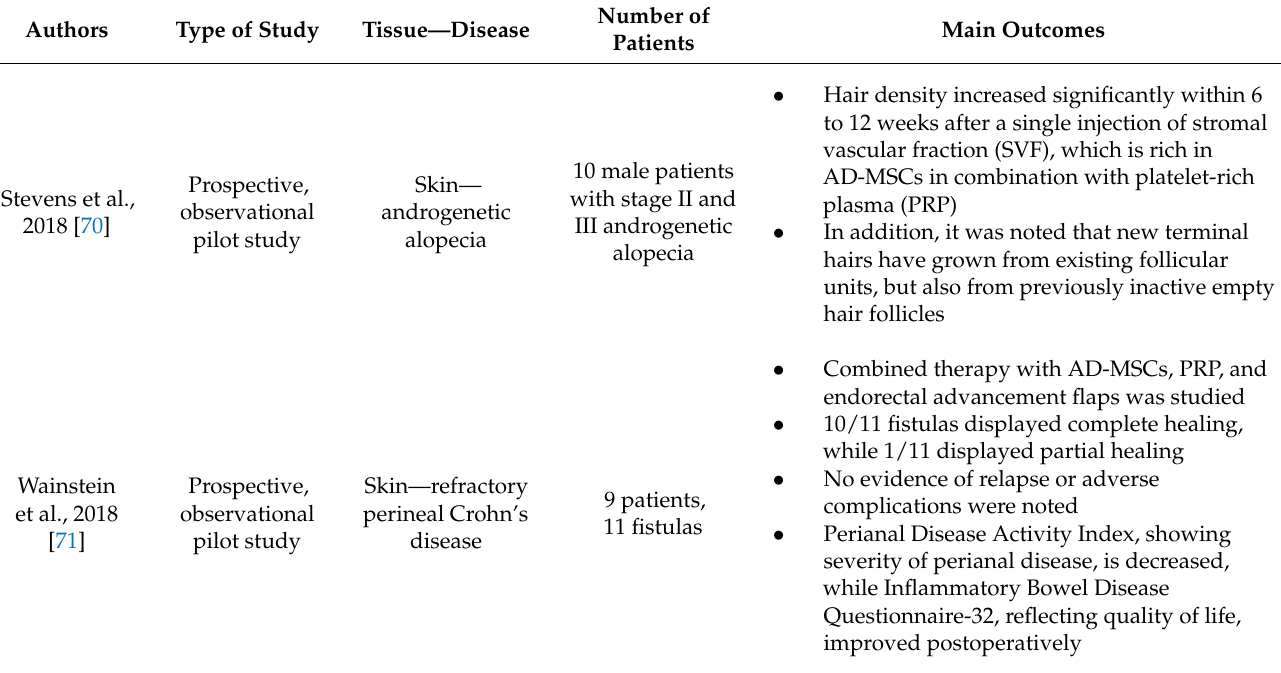
Table 3. Applications of the combined use of ADMSC and PRP in clinical